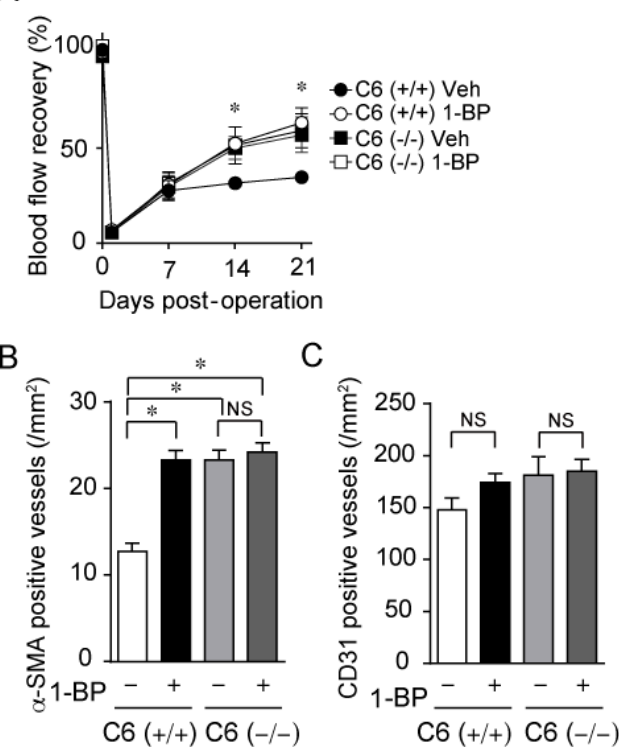
Figure 7. 1-BP promotes arteriogenesis via TRPC6 inhibition. ( A ) Averaged time courses of blood flow recovery after HLI in 129/Sv wild type (C6 (+/+)) and TRPC6-knockout (C6 ( − / − )) mice with 1-BP or vehicle (Veh) (n = 6 mice per genotype and treatment). ( B ) Quantitative result of the number of α -SMA positive vessels in either C6 (+/+) or C6 ( − / − ) ischemic gastrocnemii with or without 1-BP (n = 5 mice per genotype and treatment). ( C ) Quantitative result of the number of CD31 positive capillary in either C6 (+/+) or C6 ( − / − ) ischemic gastrocnemii with or without 1-BP (n = 5 mice per genotype and treatment). Data are mean ± s.e.m. * p < 0.05. Comparisons were made using Two-way ANOVA followed by Tukey’s multiple comparison tests ( A ) or One-way ANOVA followed by Tukey’s multiple comparison tests ( B , C